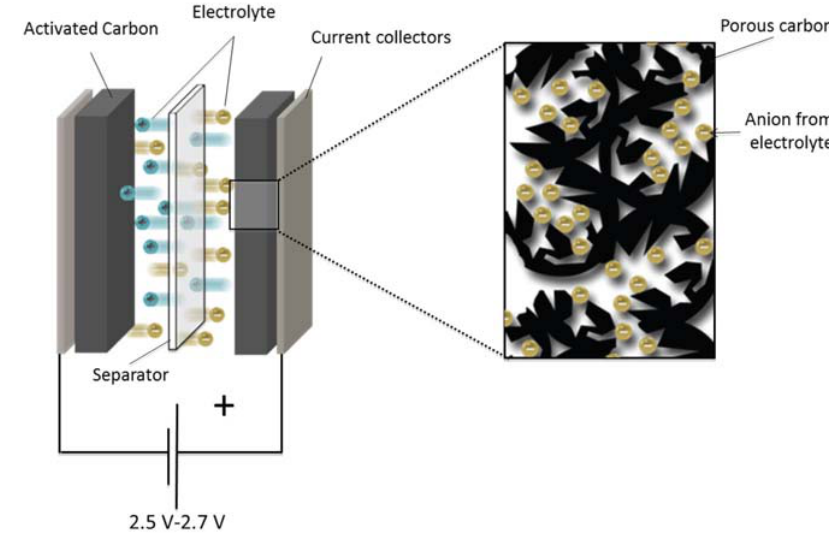
Figure 1 : Schematics of a supercapacitor (left) and porous carbon at the positive electrode containing adsorbed